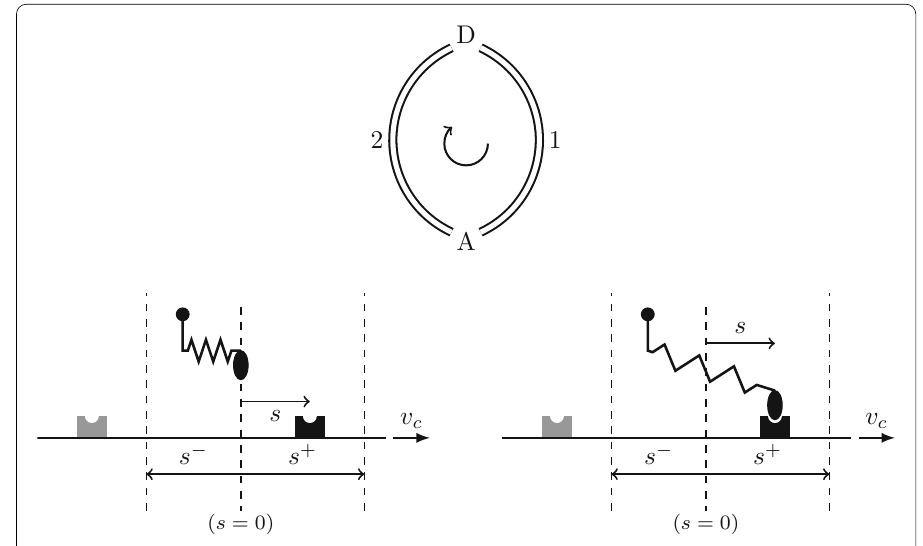
Fig. 2 Huxley’57 model representation. Top: definition of the transitions between the attached state (A) and the detached state (D). Bottom left: model parametrization, representation in the detached state. Bottom right: model parametrization, representation in the attached state. The position of the actin site corresponding to s = 0 is represented by a thick dashed